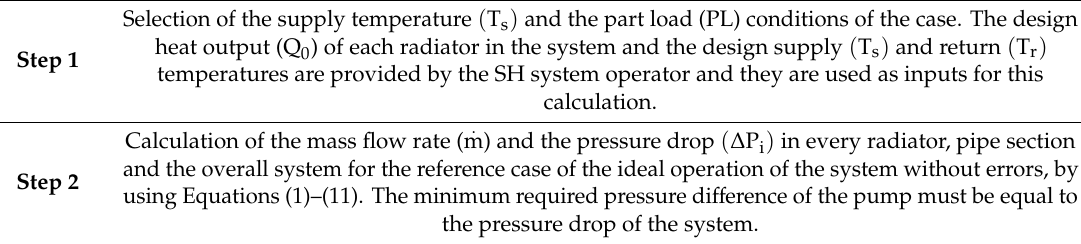
Table 2. An overview of the calculation process performed by the thermal-hydraulic model in order to calculate the mass flow rate, the pressure di ff erence of the pump and the return temperature of the radiator system under the ideal operation without problematic operation by the thermostatic